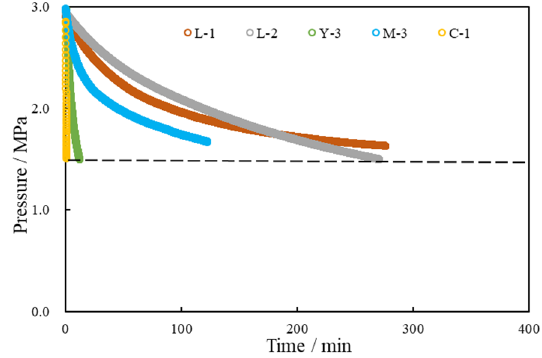
Figure 9. The influence of roughness characteristics on fracture connectivity.